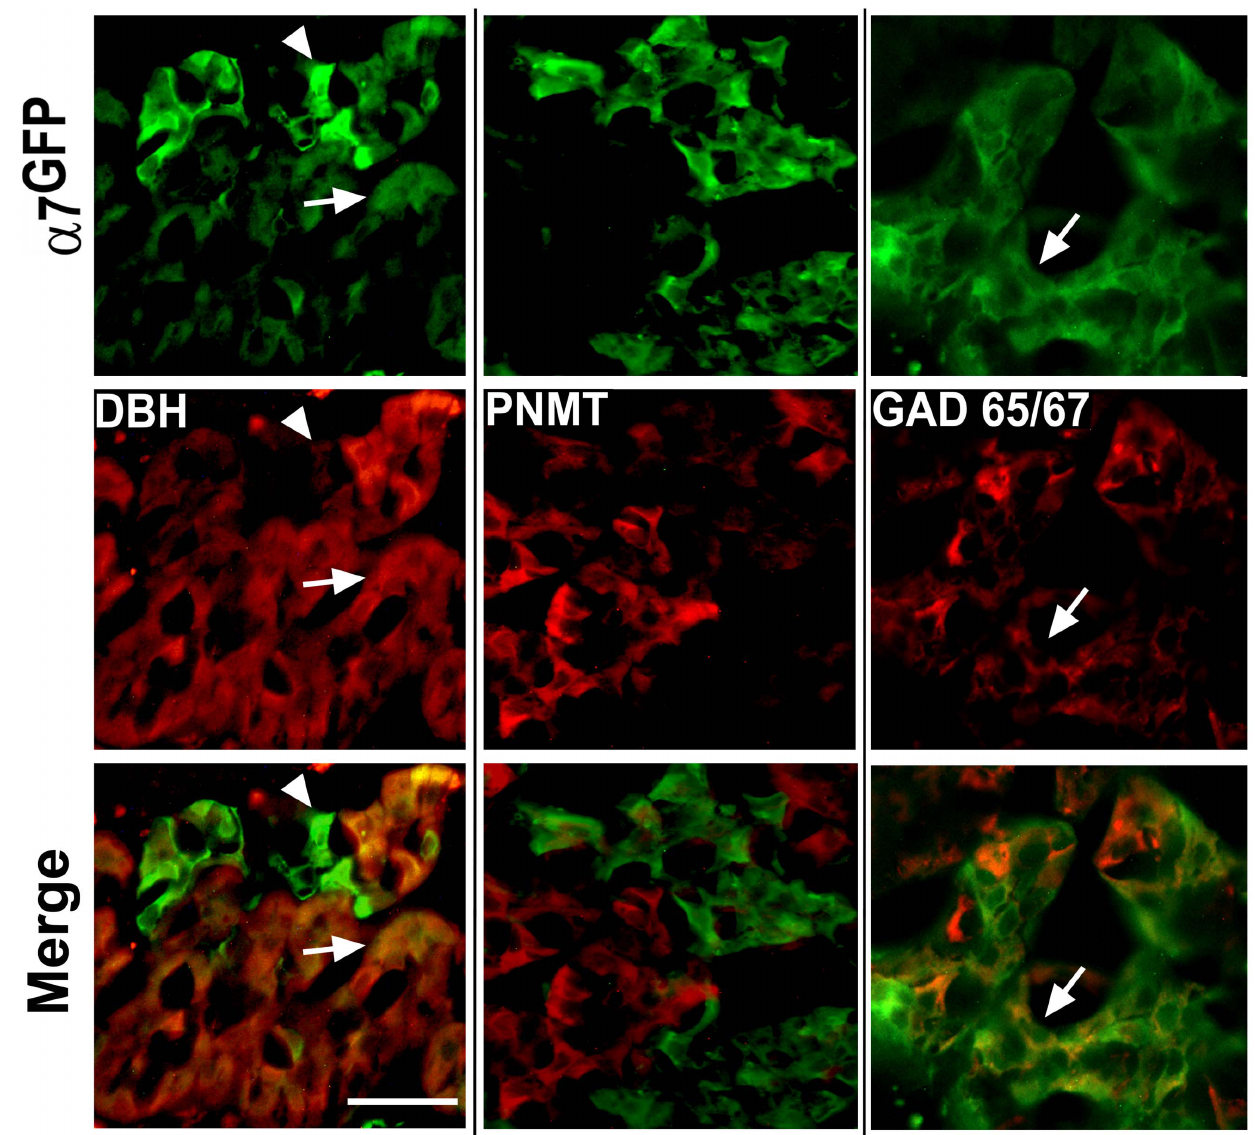
Figure 4. Co-expression of a 7 G , catecholamine markers and GAD65/67 in the adult adrenal medulla. Adult adrenal medulla immunostained for a 7 G or DBH, PNMT or GAD 65/67 as identified. Cells expressing a 7 G as measured by GFP immunofluorescence (green) are present and they tend to be clustered towards the adrenal medulla-cortex boundary (arrow). Some a 7 G expression is localized to cells which are smaller and more solitary but exhibit a particularly strong GFP signal (arrow head). As shown most a 7 G cells co-express DBH (arrow), but the more solitary cells do not (arrow head). In contrast co-expression of a 7 G and PNMT has not been observed. The staining for GAD65/67 is largely discordant from that of a 7 G although rare cells expressing both markers are identified (arrow). The extensive staining by GAD65/67 can also be found in some afferent fibers that are often associated with cells in clusters that express a 7 G as is seen at greater magnification (cluster identified by the arrow). Scale bar =50 m m.